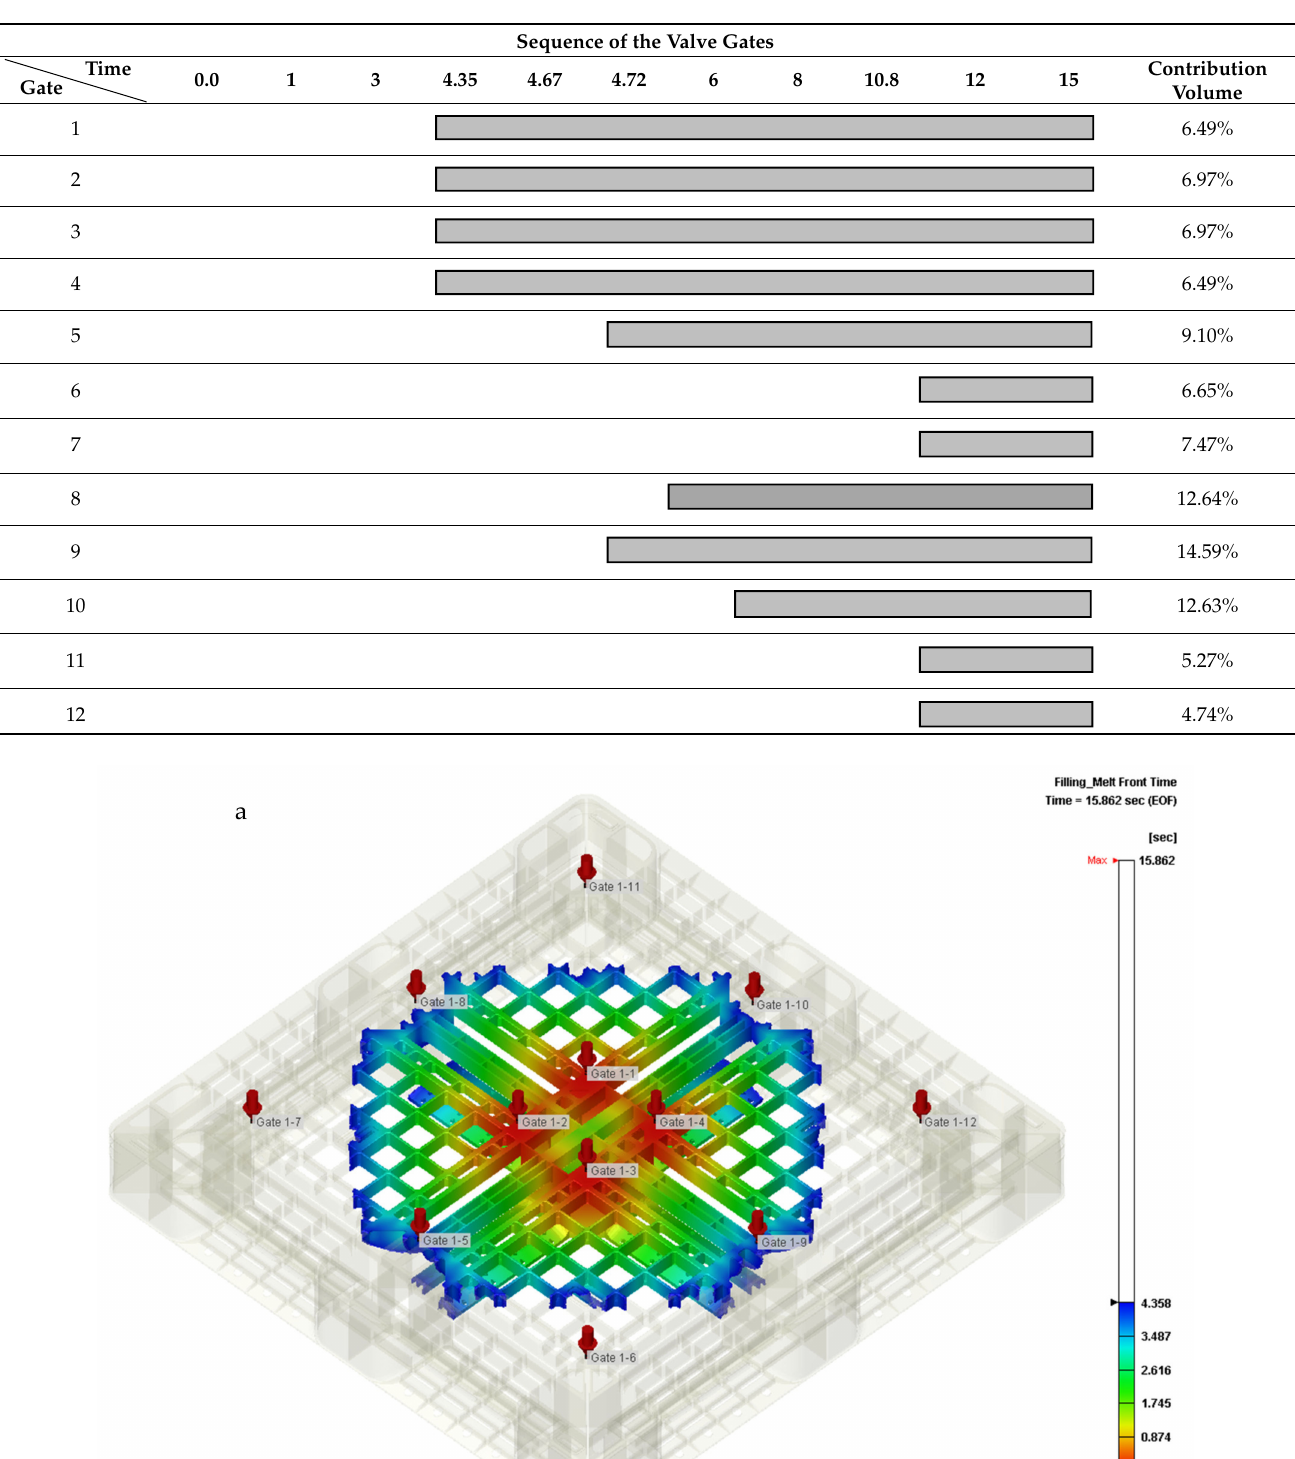
Table 5. Switching times for the proposed sequence of the filling valve gates.